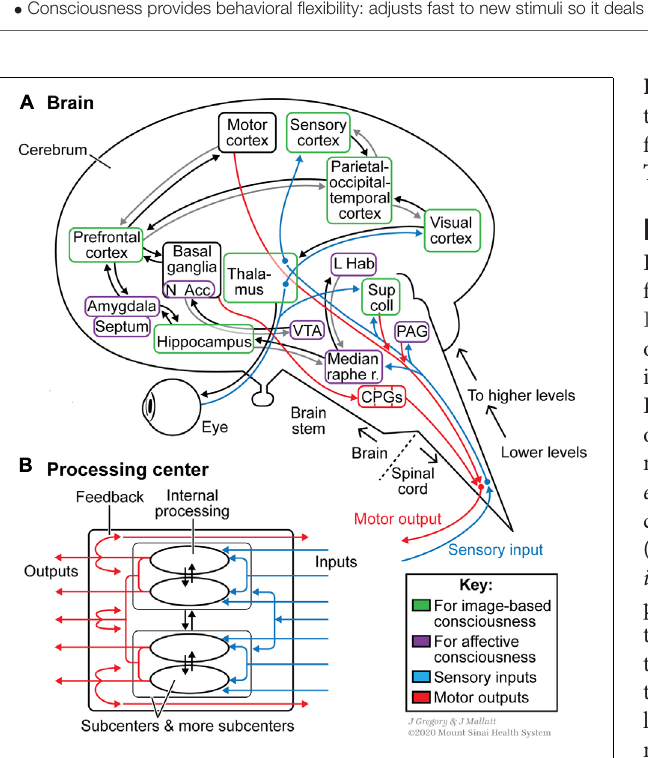
evolved in sequence and represent increasing biological and neurobiological complexity ( Table 2 ). Each level displays novel emergent features, plus the features that emerged in the levels below it, plus the general features of all complex